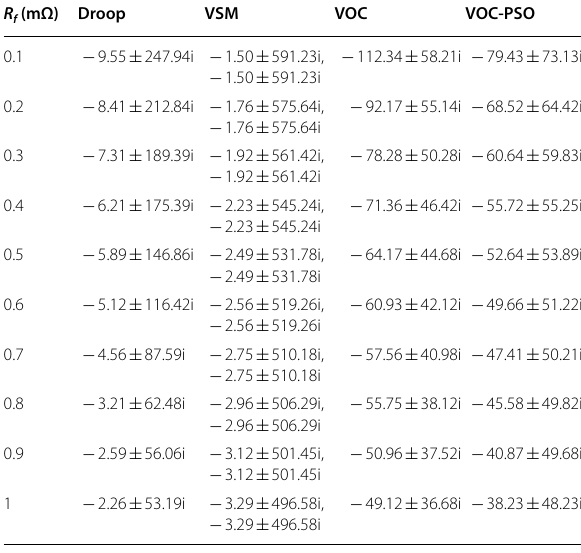
Table 2 Eigenvalues for different filter resistor